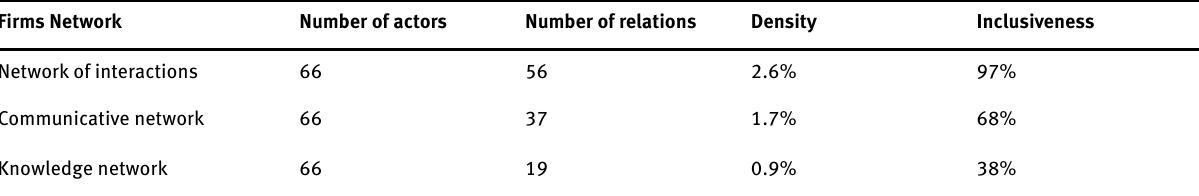
Table 1: Firms network indexes Firms